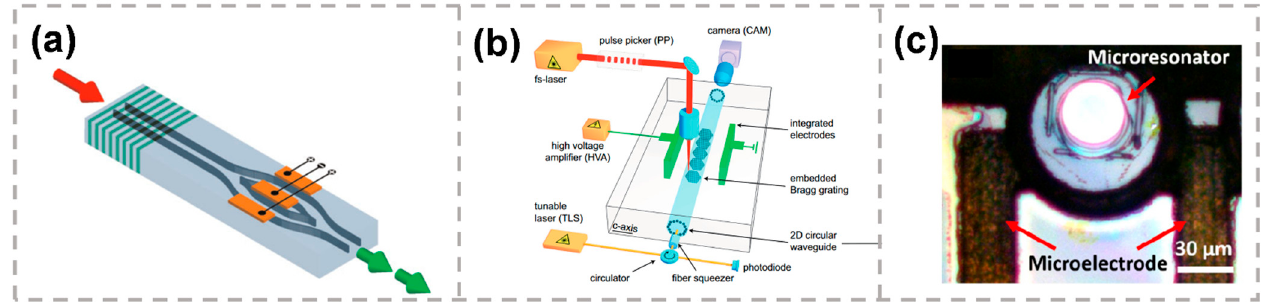
Figure 6. ( a ) Schematic of a hybrid fs laser-written chip including an amplitude modulator [83]. ( b ) Schematic of the experimental setup for direct integration and characterization of waveguide embedded Bragg gratings (WBG) in LiNbO 3 [86]. ( c ) The top view of the EO tunable LiNbO 3 microresonator integrated with in-plane microelectrodes [88]. Reproduced from [83] with permission of the John Wiley and Sons, 2022. Reproduced from [86] with permission of the Optica Publishing Group, 2022. Reproduced from [88] with permission of the Springer Nature, 2022.